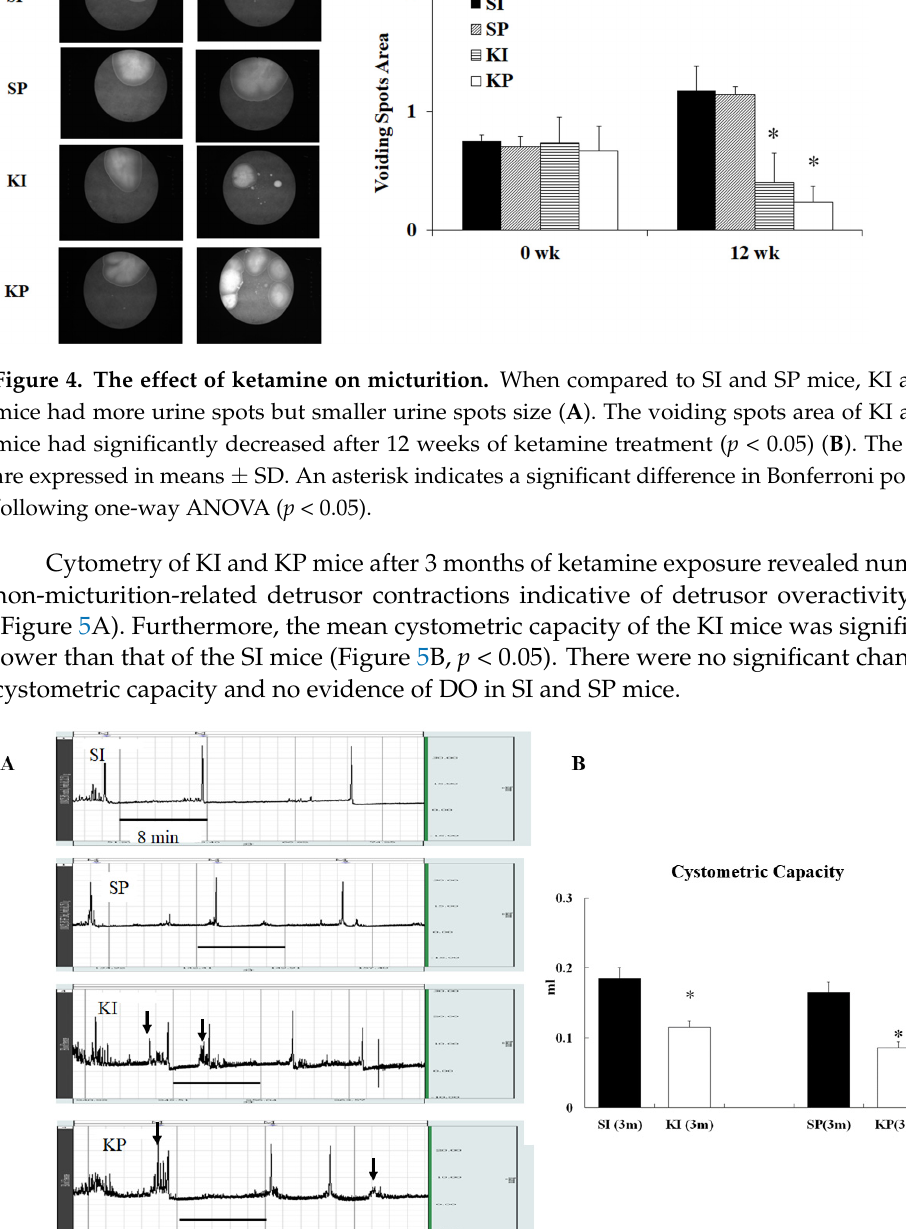
Figure 3. The effect of ketamine inhalation on behavior during the open field test (OFT). KI and KP mice had increased locomotor activity tracks, but SI and SP mice did not ( A ). KI and KP mice had higher center crossing frequency, center travel distance, and peripheral distance when compared to SI and SP mice ( p < 0.05) ( B ). The values are expressed in means ± SD. An asterisk indicates a significant difference in Bonferroni post-tests following one-way ANOVA ( p < 0.05).